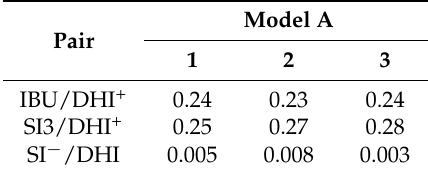
Table 1. Coordination numbers for the most important pairs of the model.